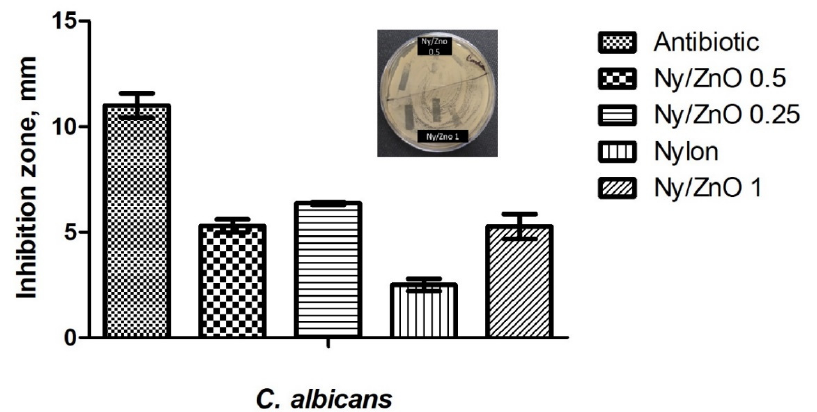
Figure 5. Effect of antibiotic, nylon, Ny/ZnO 1, Ny/ZnO 0.5, Ny/ZnO 0.25 on the growth of C. albicans .